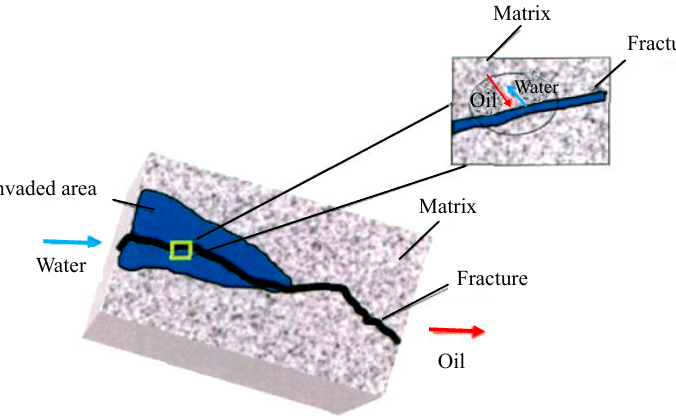
Figure 12. Schematic of the imbibition effect on oil recovery in tight porous media with fractures.